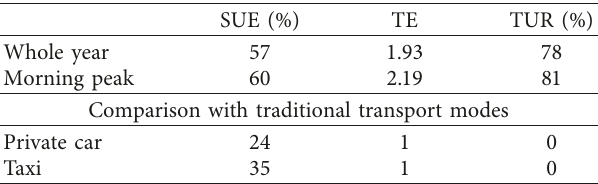
Table 5: Calculation results of bus sharing recommended indi- cators in Xiong’an New Area.